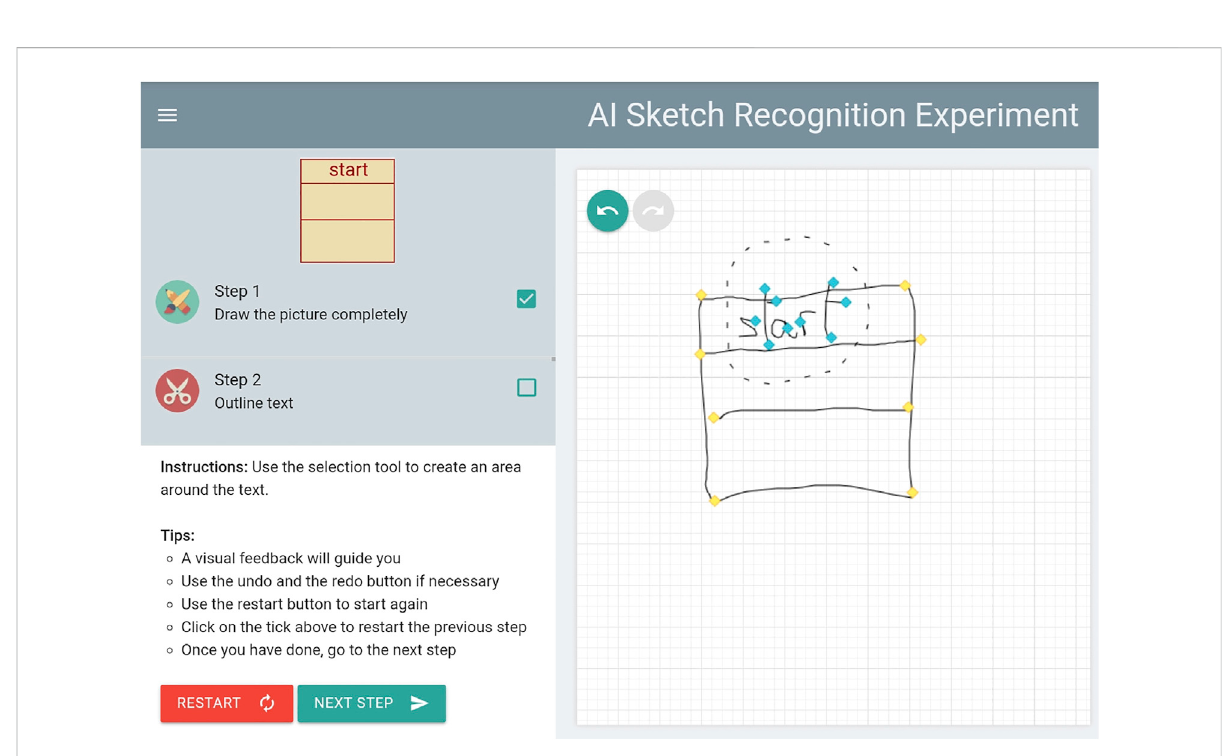
FIGURE 7 Upon completing a sketch, participants are asked to select (using a Lasso Tool) the text only. Sharp corners are shown in yellow. They turn blue once they have been selected.